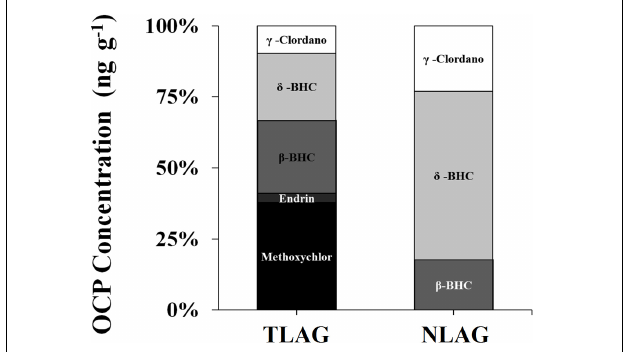
statistical differences ( p ≤